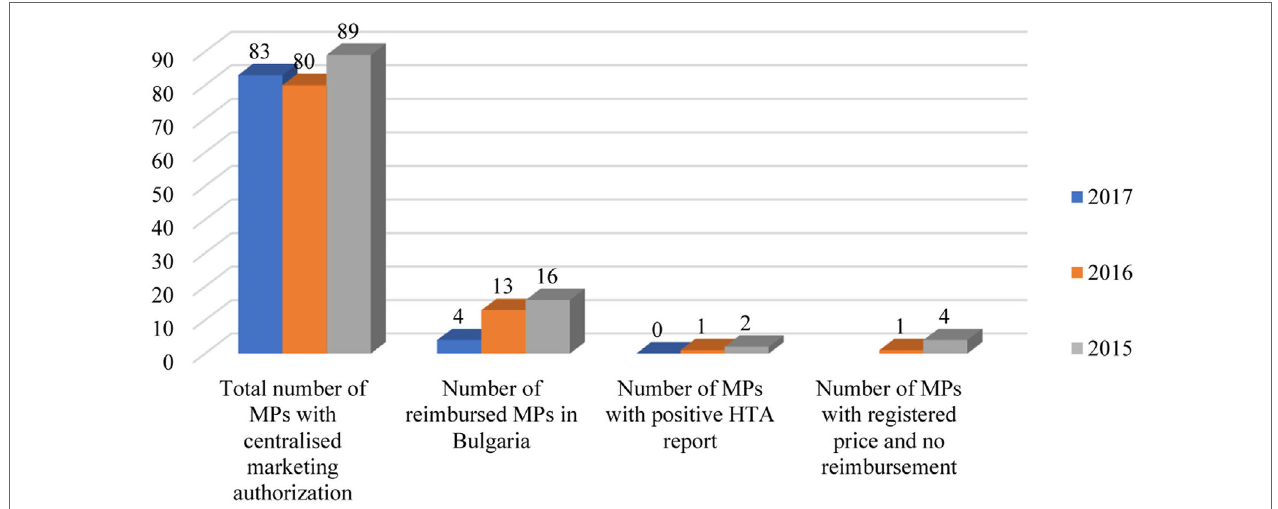
Figure 3 | Reimbursement status of MPs in Bulgaria authorized through centralized procedure in the EU. Abbreviations: MA, marketing authorization; MPs, medicinal products; HTA, health technology